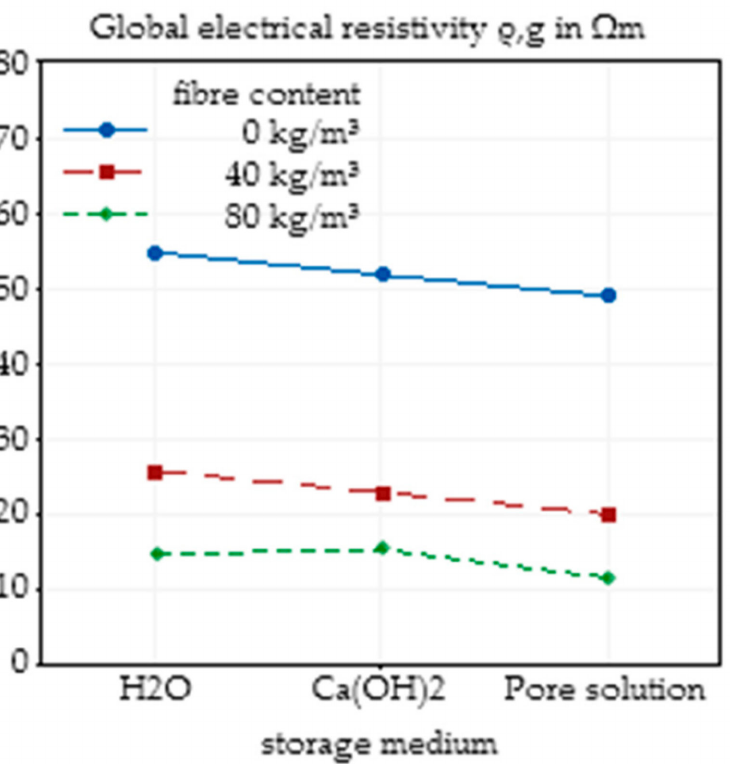
Figure 14. Effect of the storage conditions on the global electrical resistivity of SFRC depending on the fibre content based on nine specimens.